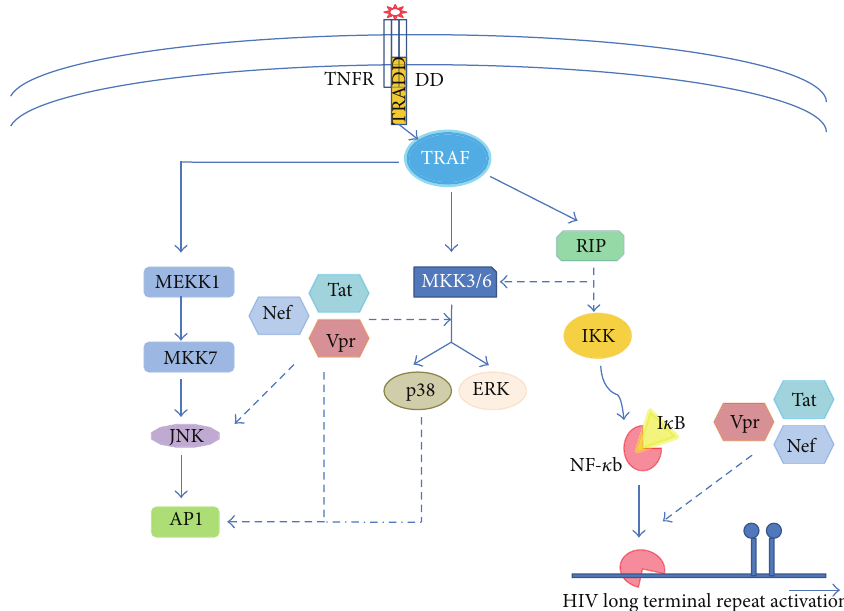
Figure 2: TNF signaling mimicking by HIV proteins. Early expressed HIV proteins Vpr, Tat, and Nef mimic TNF-alpha as they activate TNF-alpha governing signaling pathways to enhance HIV replication in infected